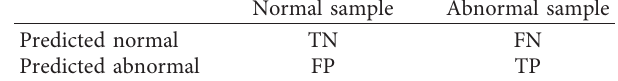
Table 3: Confusion matrix of the binary classification. Normal